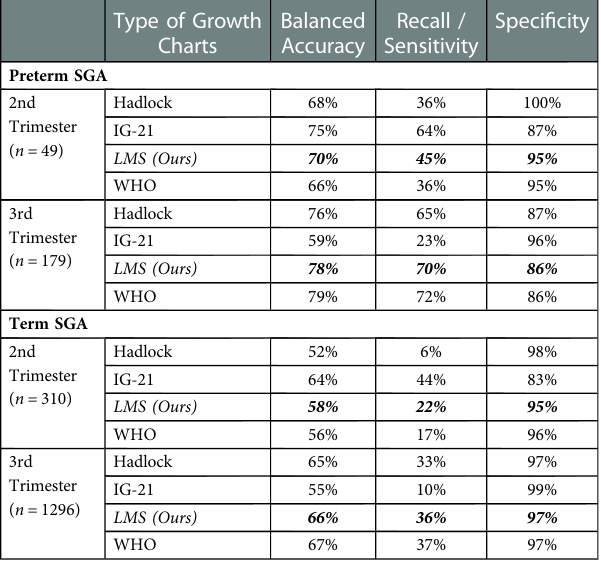
TABLE 5 Result of different fetal growth reference charts in predicting SGA for preterm and term infants in 2nd trimester and 3rd trimester. Type of Growth Balanced Recall / Speci fi Charts Accuracy Sensitivity